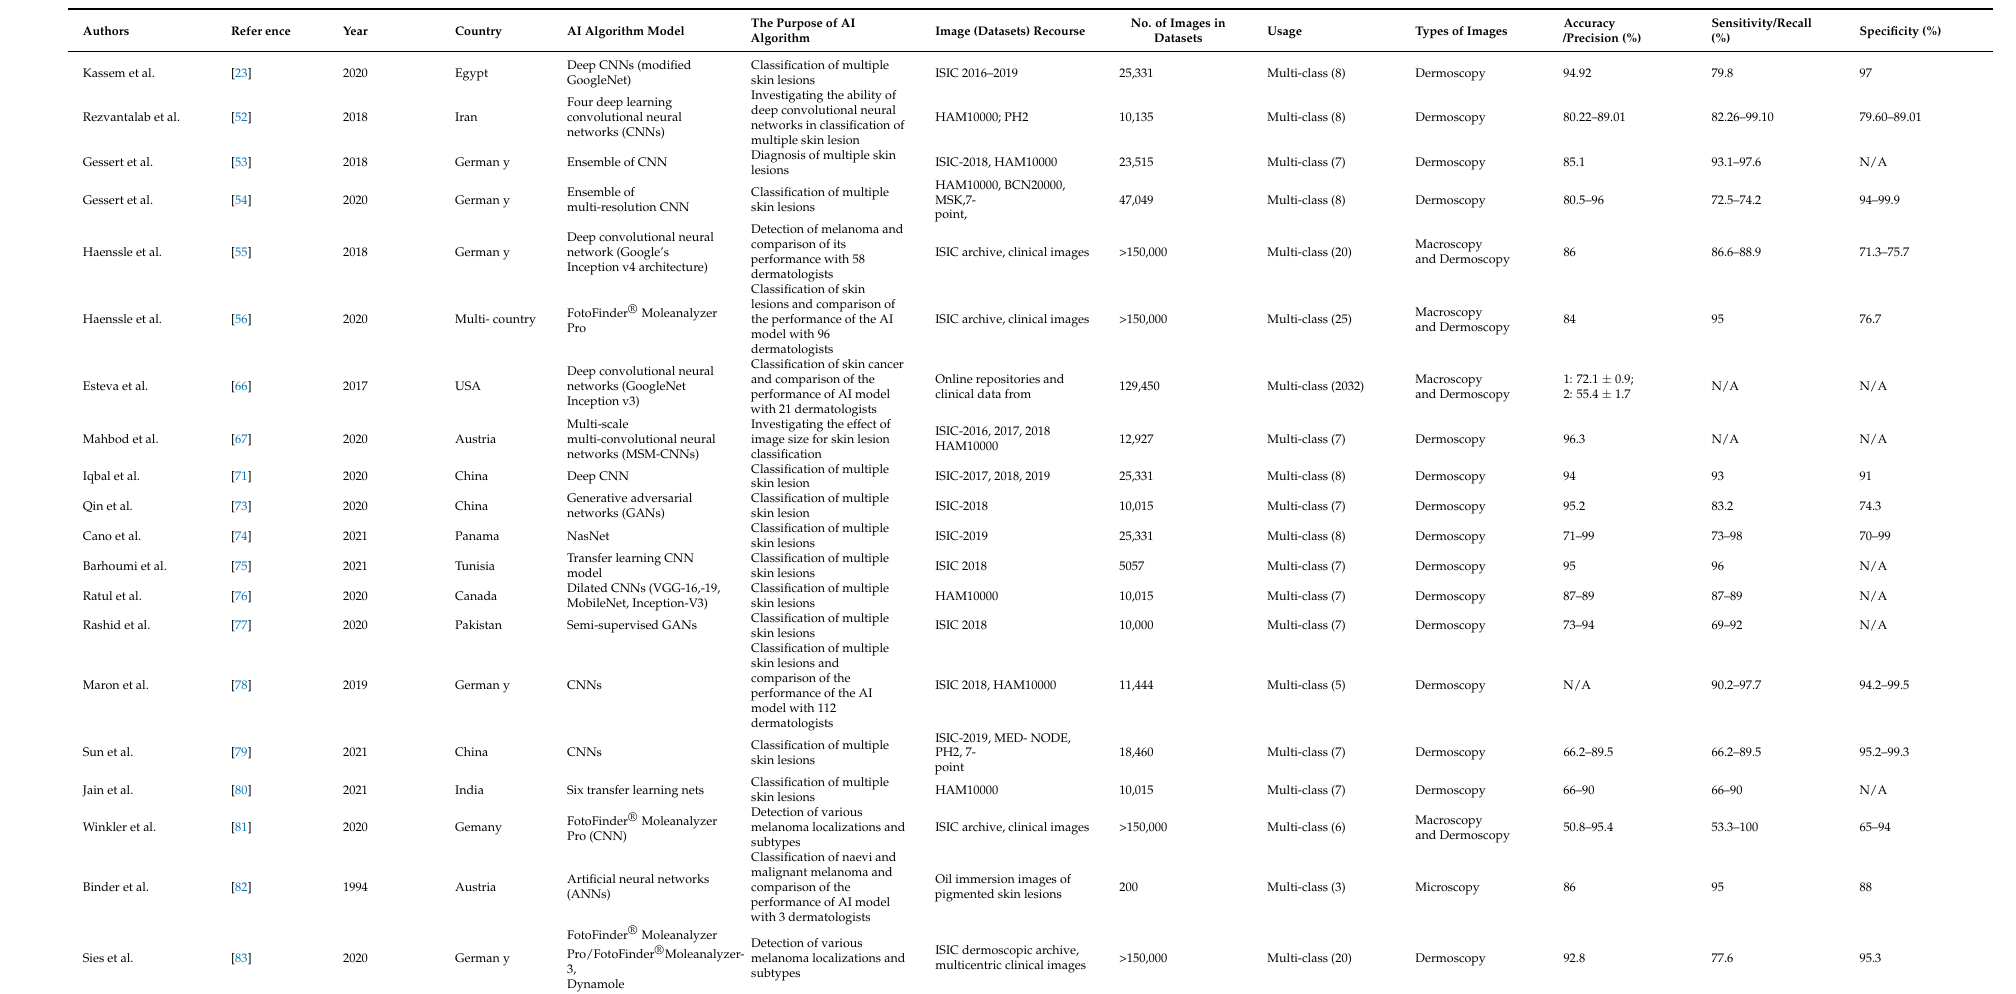
Table 2. The application of AI in multi-classification for skin